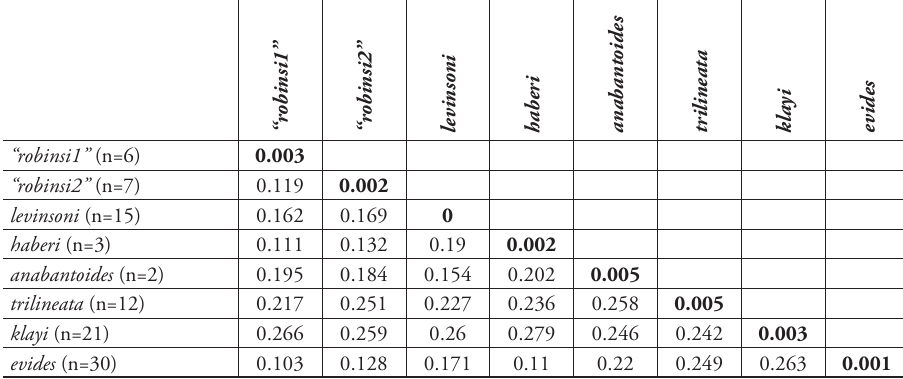
Table 3. Average Kimura two-parameter distance summary for species of Lipogramma based on cy- tochrome c oxidase I (COI) sequences analyzed in this study. Intraspecific averages are in bold.